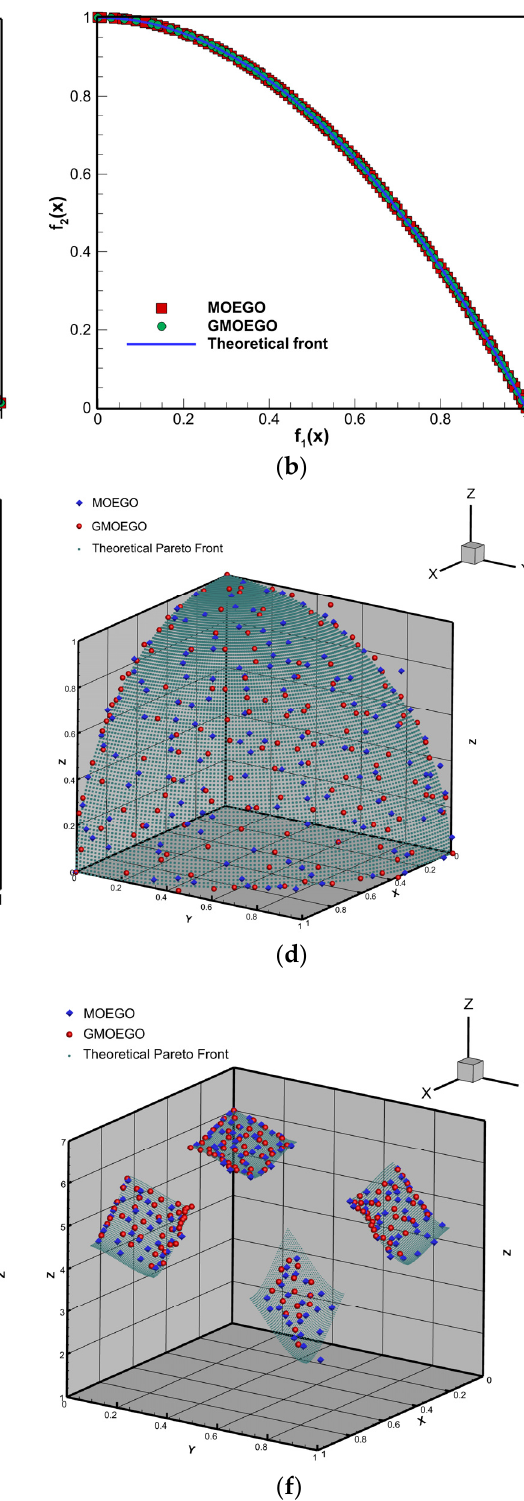
( b ) Figure 8. Wall-clock time history comparisons: ( a ) ZDT series functions; ( b ) DTLZ series functions. 5. Aerodynamic Design Optimization In order to investigate the performance of the proposed GMOEGO algorithm in real engineering optimization applications, an aerodynamic airfoil shape optimization case [46] is selected to test the algorithm. The baseline of the airfoil is RAE2822 under the